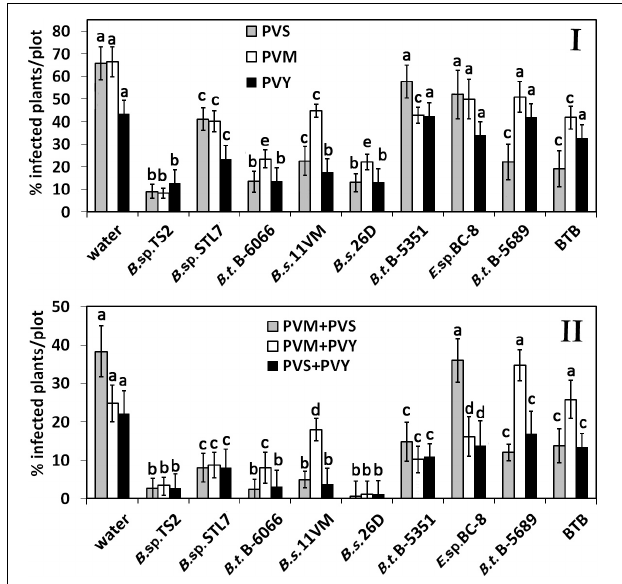
FIGURE 2 | Effect of bacterial agents and Bitoksibacilline (BTB) treatments of potato plants on the prevalence of potato virus Y (PVY), potato virus M (PVM), and potato virus S (PVS) on potato plots on the 17th day after treatment: percentage of samples that tested positively for each virus (I) and samples that tested positive for two viruses simultaneously (II) . Data represented as mean values ± standard error; values followed by the same alphabet within a column are not significantly different from each other according to Tukey’s honestly significant difference (HSD) multiple-range test at P <